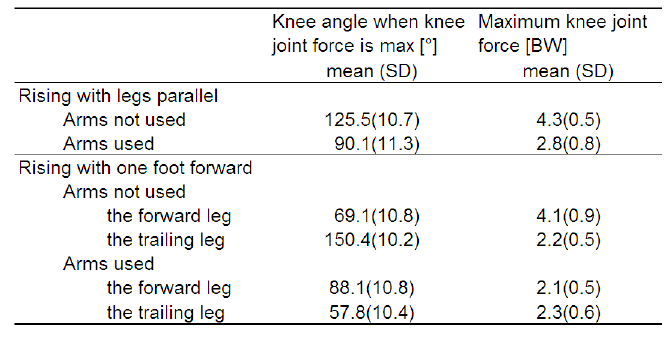
Table 2 Knee angle when knee joint forces become maximum and the maximum knee joint